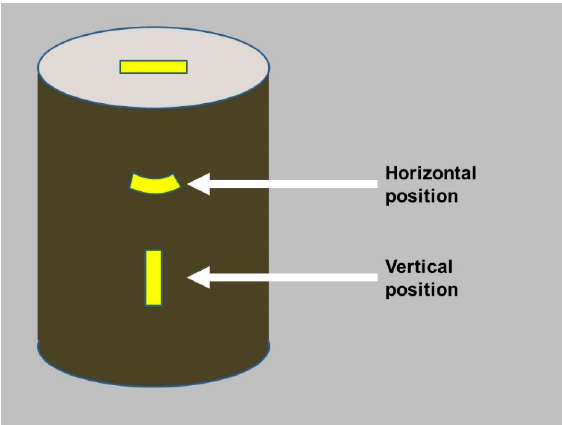
Figure 2. Positions of application of tags on the trunk of the tree. In case of logs or felled trees, tags could also be placed on the crosscut section.